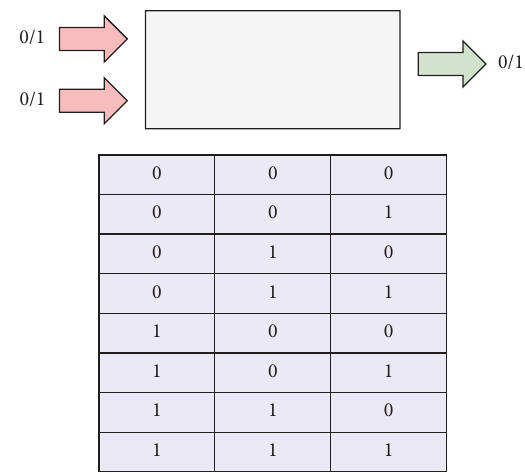
Figure 1: Example of variety.